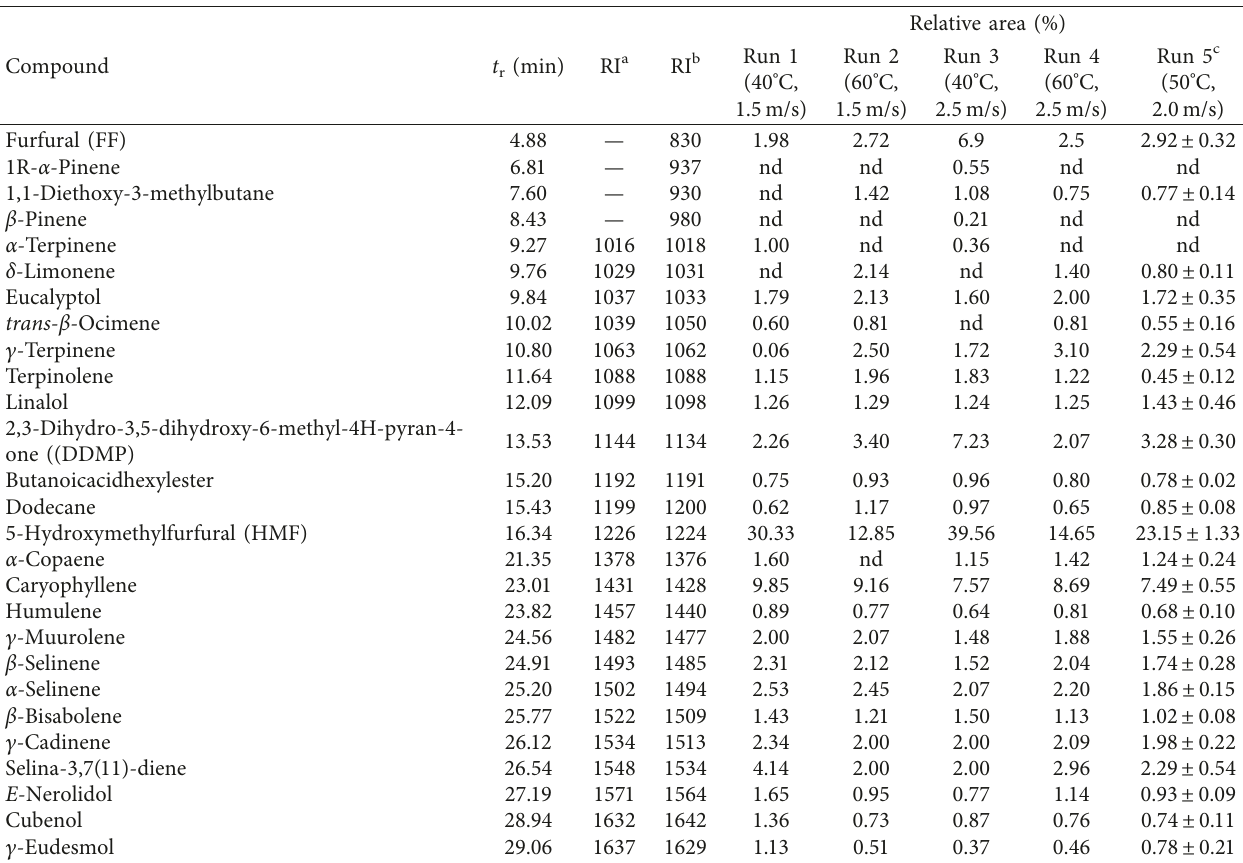
Table 4: Chemical composition (%) of the volatile fraction of ethanolic extracts of red araç´a fruits obtained at different drying conditions.